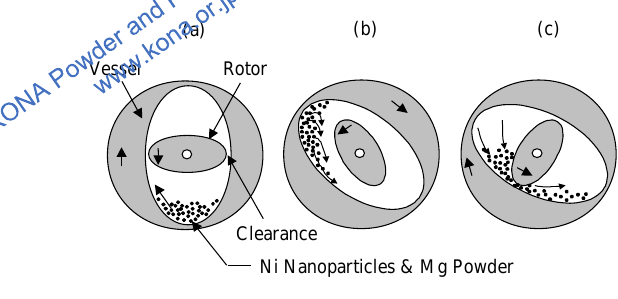
Schematic of Dry Particle Coating